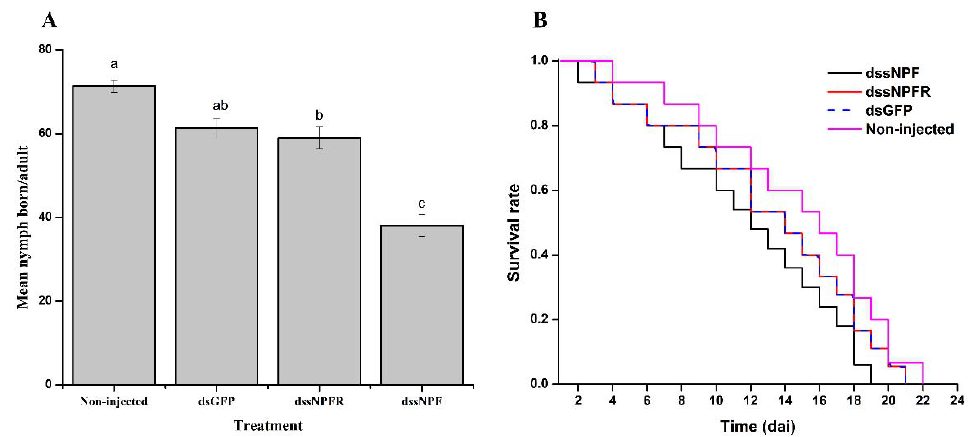
Figure 7. Influence of sNPF silencing on A. pisum reproduction and survival. ( A ) Reproduction rates in the sNPF group and the two control groups. The bars correspond to the average of three independent biological replicates. Different letters on bars indicate the statistical difference at the 0.05 level. ( B ) Survival analysis by Kaplan–Meier log ‐ rank analysis showed no difference in survival between the sNPF treatment group and the control group ( p > 0.05). Acronym used on X ‐ axis: dai (days after injection).